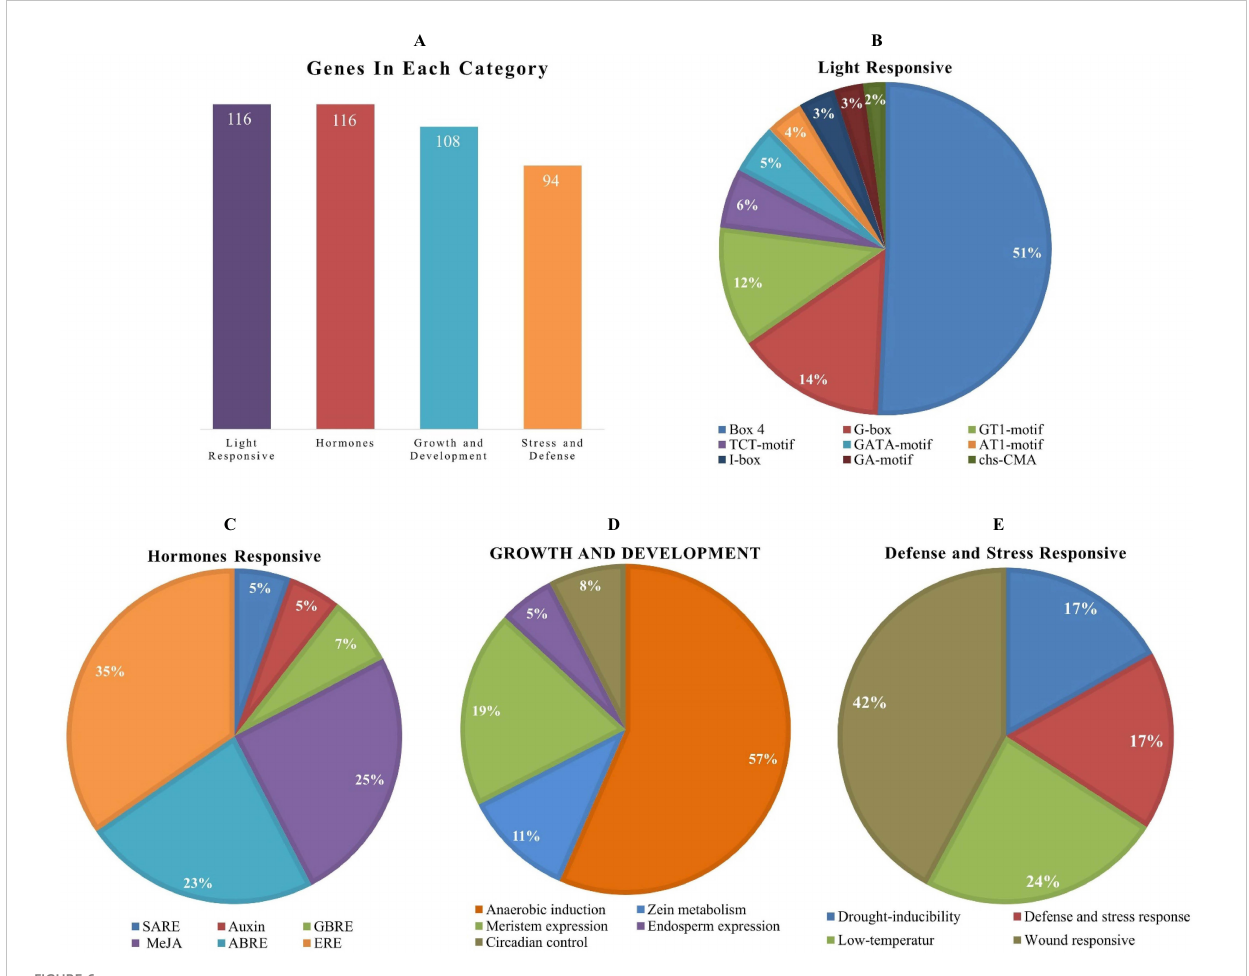
FIGURE 6 Cis -regulatory elements of AhOMT promoters. (A) The number of genes in different categories of elements. (B) Composition of light-responsive, (C) hormone-responsive, (D) growth and development responsive, and (E) stress-responsive